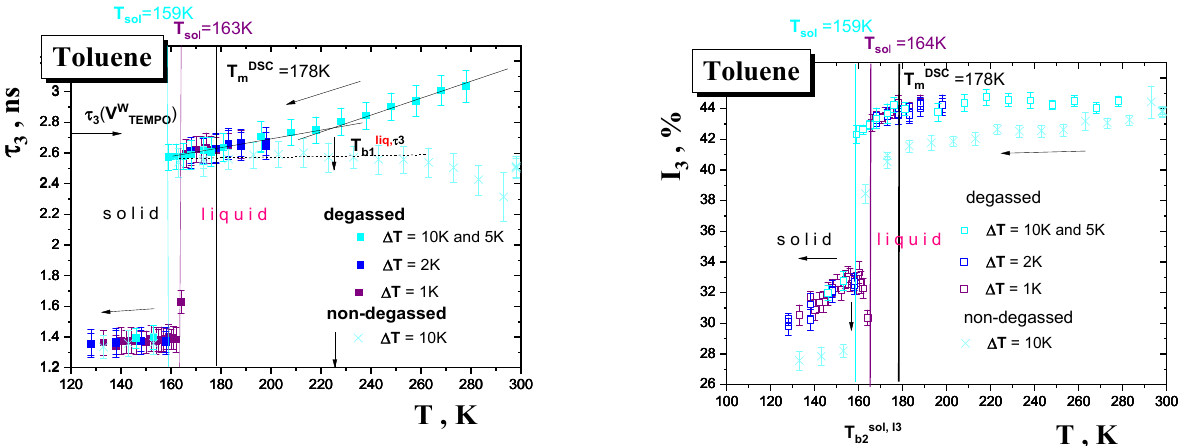
Figure 4. o-Ps annihilation parameters of TOL obtained during heating runs: heating from 110 K to 195 K after slow cooling (sc) in the degassed state (pink); heating from 128 K to195 K after rapid cooling (rc) in the non-degassed state (olive). The characteristic PALS temperatures are mentioned and discussed in the text. The basic thermodynamic temperatures from cold crystallization at T cc,onDSC and melting at T m,onDSC together with the characteristic dynamic temperatures of the two structural relaxation models ( T X , T mc )—see section 4—are also included.